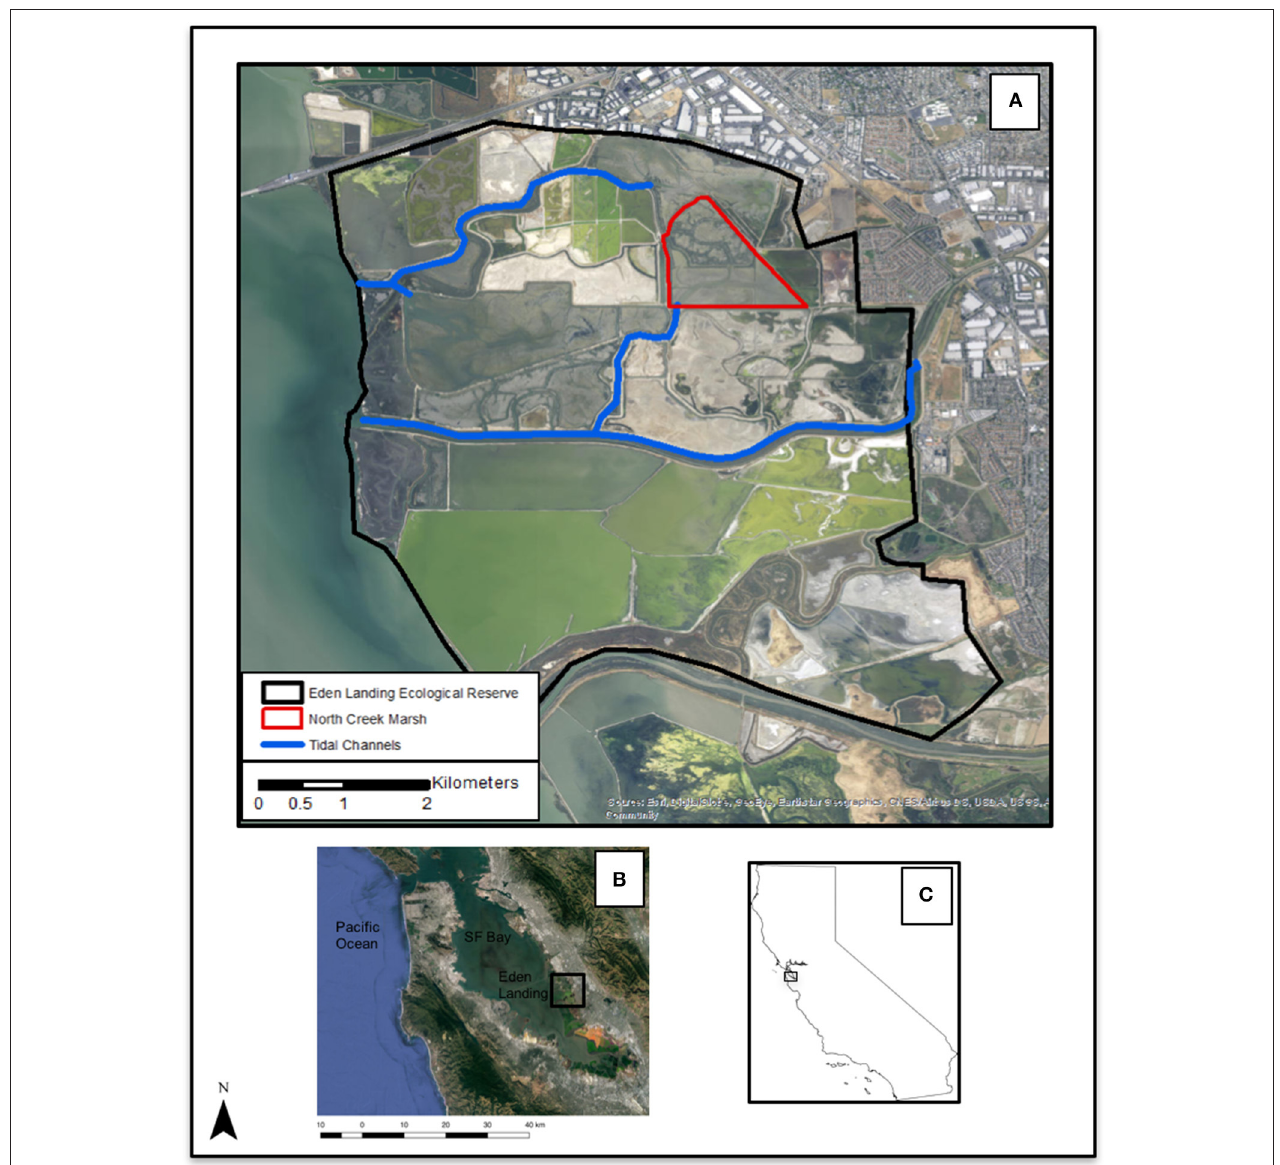
FIGURE 1 | (A) Eden Landing Ecological Reserve (CA Dept. Fish and Wildlife), Hayward, California, USA. (B) South San Francisco Bay, Eden Landing Ecological Reserve outlined (C) California state outline. Aerial images reproduced with permission from © Google, 2017.